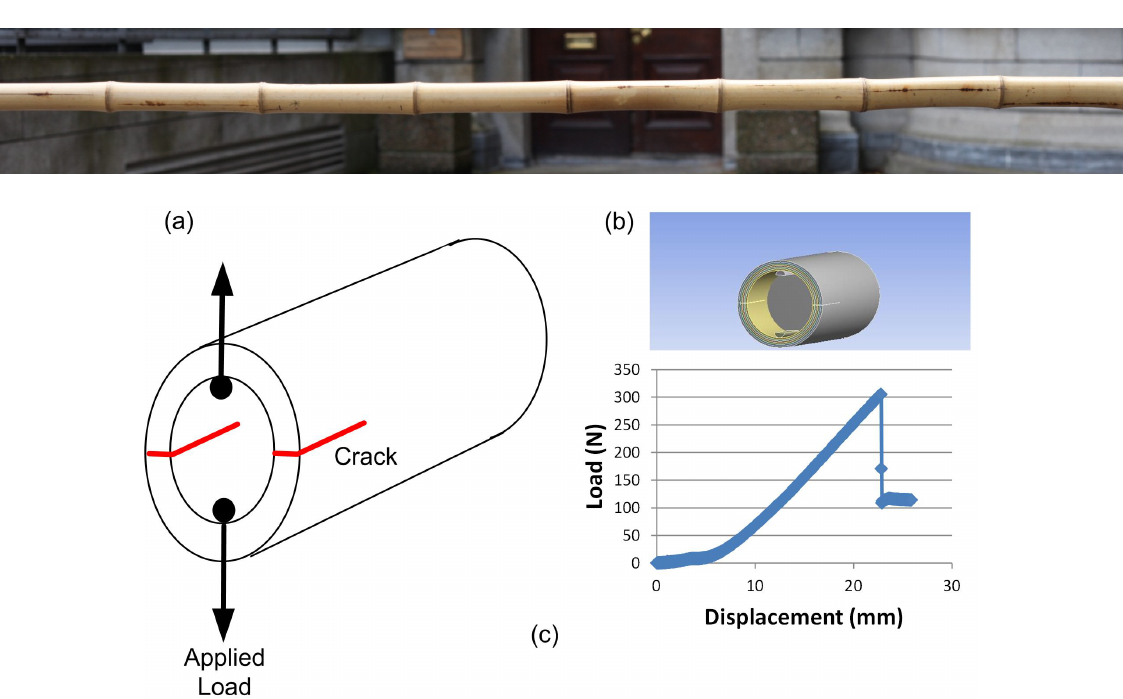
Figure 2: (Photograph): the bamboo culm consists of a hollow tube with periodic nodes. (a) We measured K c by propagating cracks along the tube axis by means of a pair of point loads. (b) We constructed a finite element model including the layered structure. (c) A typical load/displacement trace from a toughness